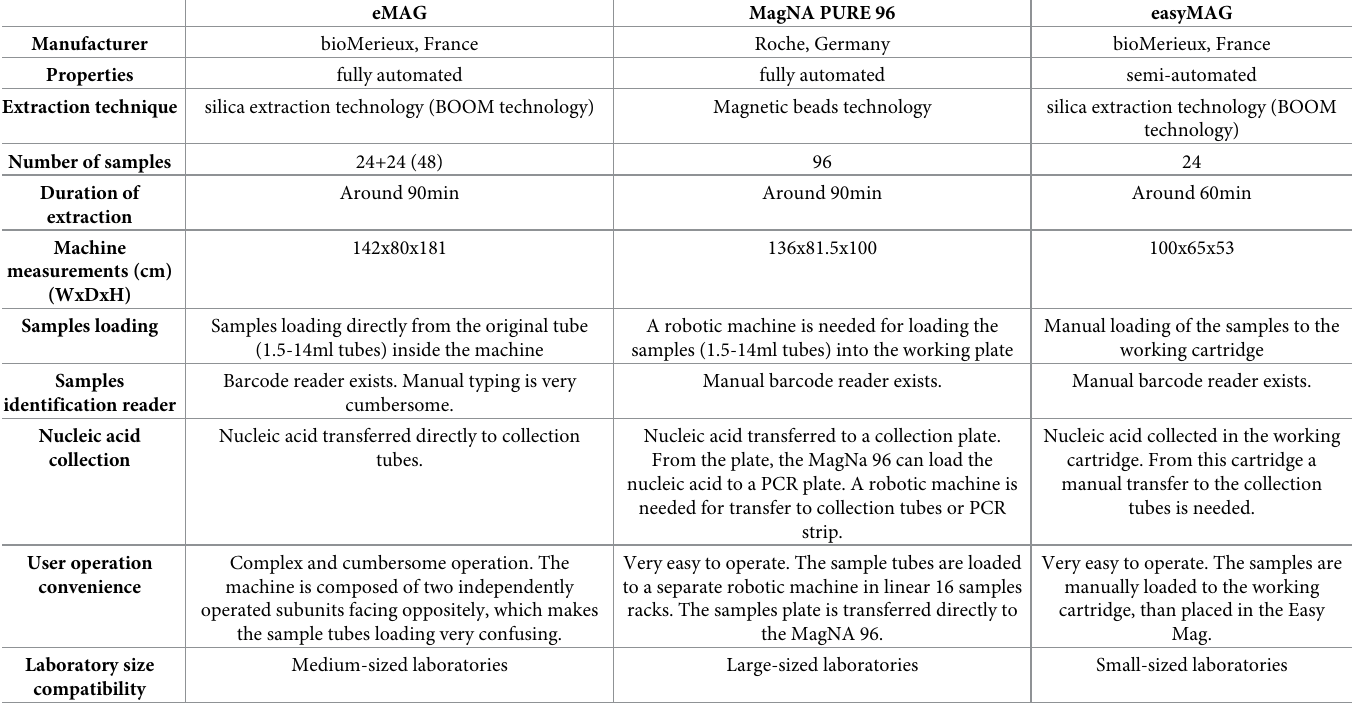
Table 1. A comparison between the technical properties and user operation convenience between the three